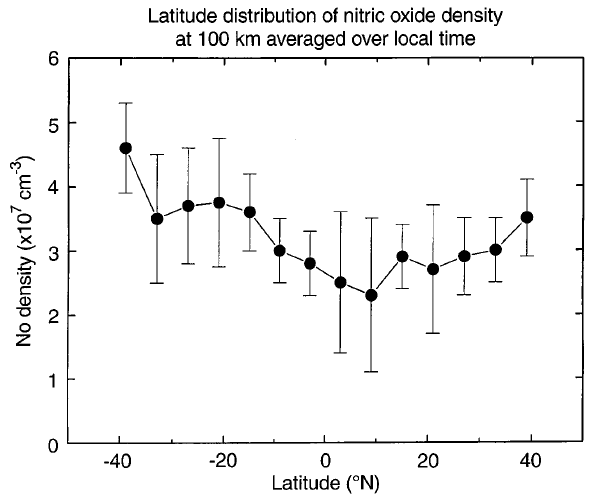
Fig. 7. The northern winter latitudinal dependence of the case B nitric oxide concentrations at 100 km obtained by averaging the profiles for all available local solar times. The error bars show the standard deviation of the densities used to obtain